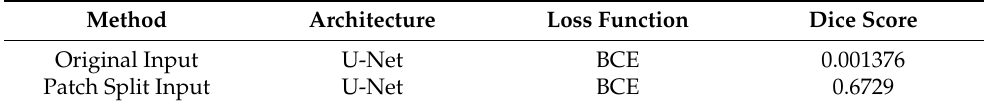
Table 3. Comparison of original input and patch-split